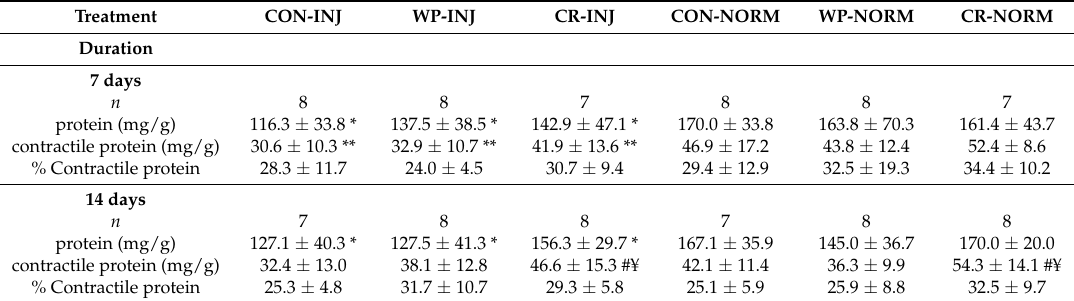
Table 3. Muscle protein content of uninjured and injured EDL muscles from rats treated with standard rat chow- (CON), whey protein- (WP), or creatine- (CR) supplemented rat chow for 7 and 14 days. Treatment CON-INJ WP-INJ CR-INJ